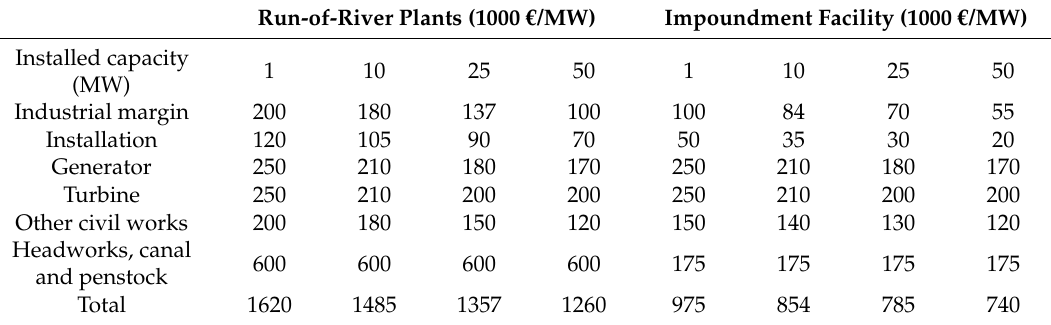
Table 5. Capital costs at hydropower plants. Source: Institute for Diversification and Saving of Energy (IDAE)